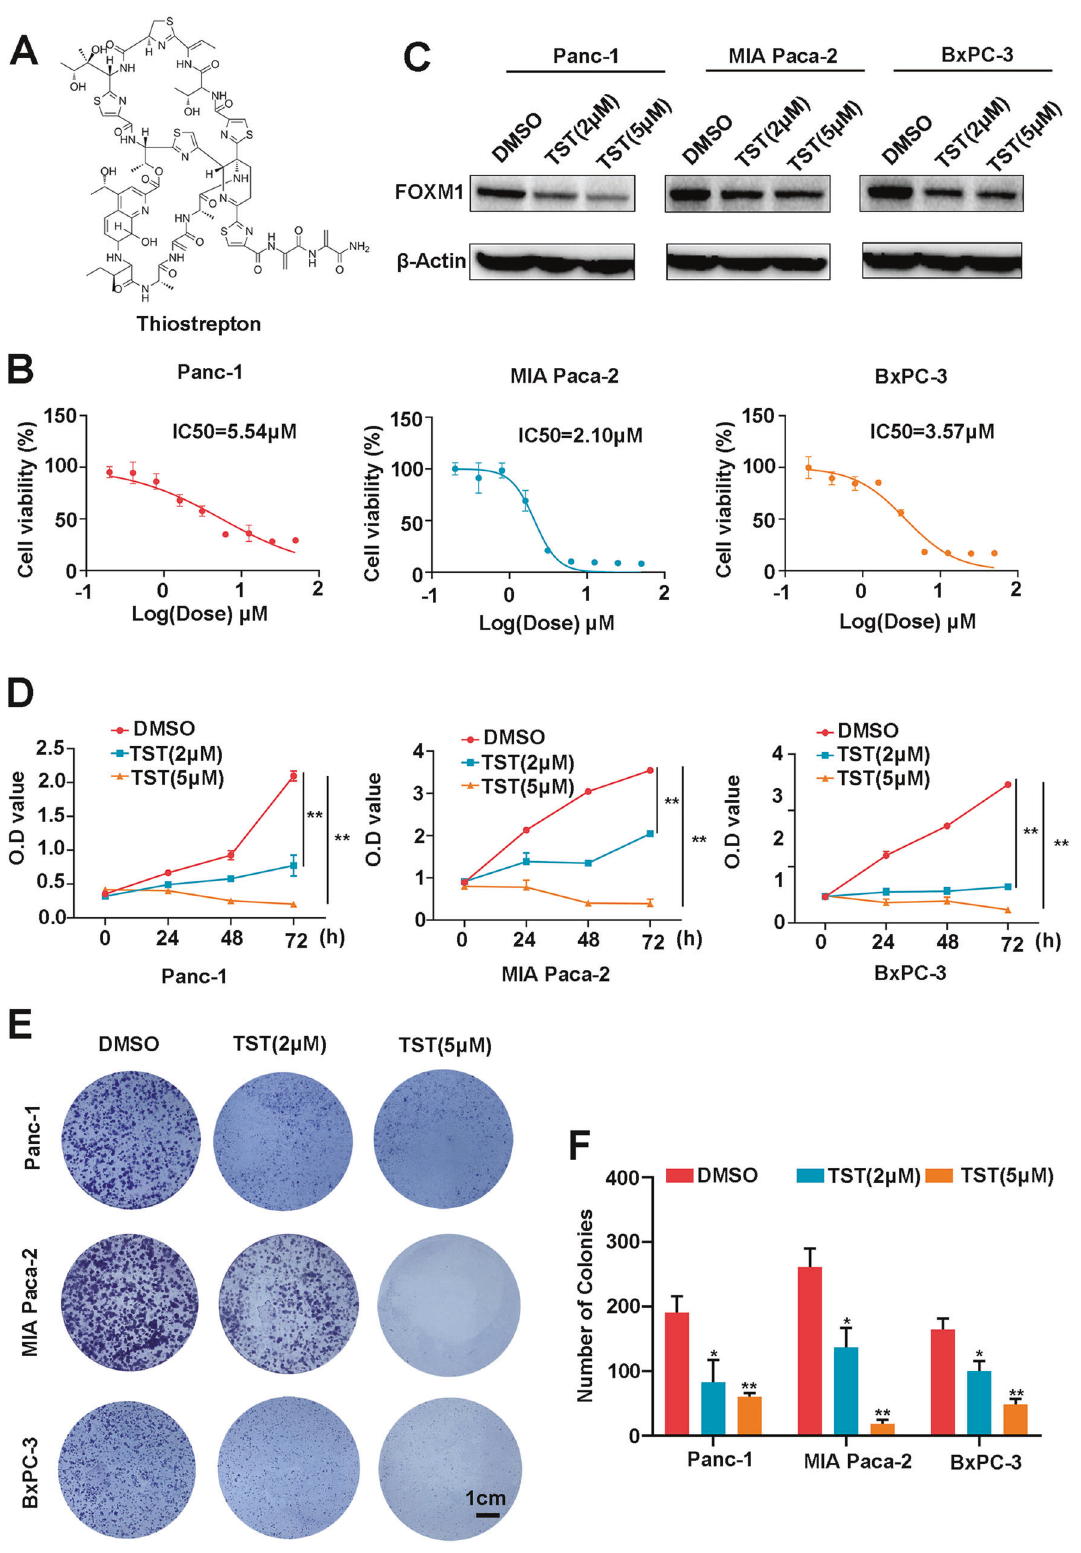
Fig. 1 Thiostrepton reduces the viability and clonogenesis of pancreatic cancer cells. A Chemical structure of TST. B Panc-1, MIA PaCa-2, and BxPC-3 cells were treated with TST (0 – 200 μ M) for 24 h, and cell viability was determined using the CCK-8 assay. C Western blotting analysis detected the level of the FOXM1 protein in different treatment groups (DMSO, 2 or 5 μ M). D OD value of the CCK-8 assay conducted at 0, 24, 48, and 72 h using pancreatic cancer cells treated with different concentrations of TST (DMSO, 2, or 5 μ M). E and F Panc-1, MIA PaCa-2, and BxPC-3 cells were treated with different doses of TST (DMSO, 2 or 5 μ M), and cell clonogenesis was measured by using a colony formation assay (* P < 0.05 and ** P < 0.01).